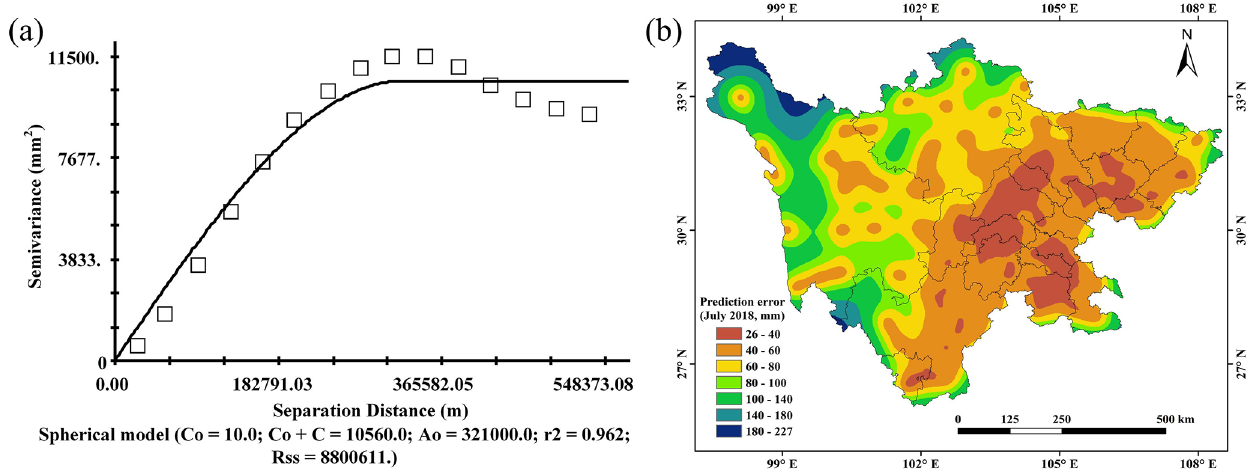
Figure 9. (a) Semivariogram, (b) prediction error. Semivariogram and prediction error map of kriging in the wettest month (July 2018).